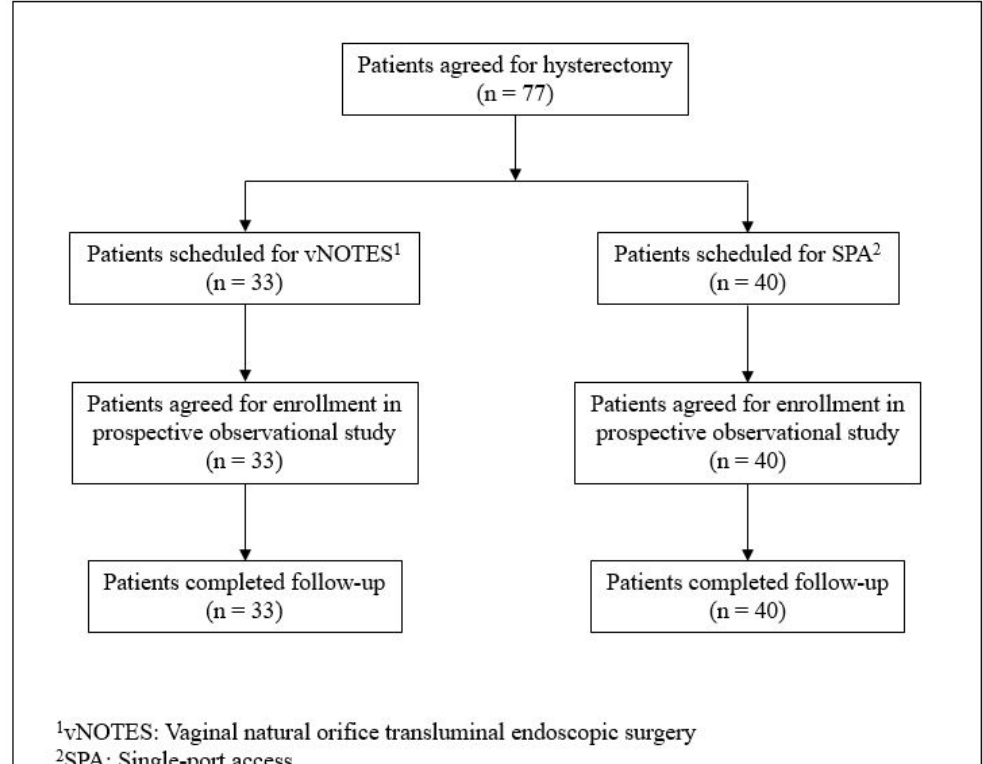
Figure 1. Study flowchart. Time measurements for each surgical procedure were compared between the two groups. As can be seen in the table (Table 3), completion of port installation took signifi- cantly longer in the vNOTES group (18 min vs. 5 min, median, p -value < 0.001). However, once the installation of the port was completed it took less time to perform the rest of the procedures in the vNOTES group than in the SPA group. The time for vaginal closure was also shorter in the vNOTES group (6 min vs. 12.5 min, median, p -value < 0.001). The median total operative time was 64 min for the vNOTES group and 82 min for the SPA group, showing a statistically significant difference ( p -value <